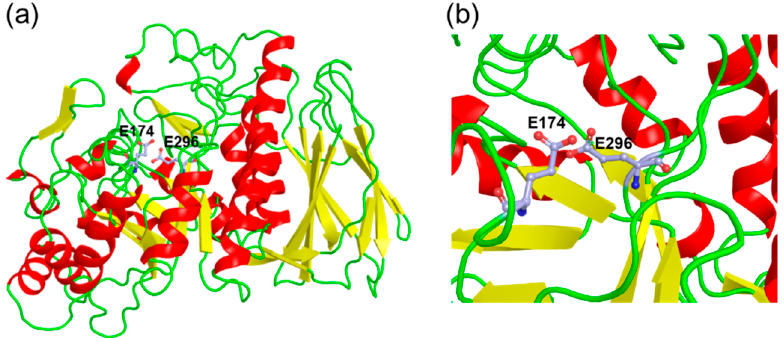
Figure 3. The three-dimensional structure model of Pp Abf51b predicted by SWISS-MODEL. ( a ) Amino acids from position 5 to position 493 of Pp Abf51b were covered by the model; ( b ) E174 and E296, labeled in light blue, are predicted to be putative catalytic residues. The root-mean-square deviation (RMSD) was determined to be 0.070 between the homology model of Pp Abf51b and the α -L-arabinofuranosidase from T. xylanilyticus (PDB ID: 2VRQ).